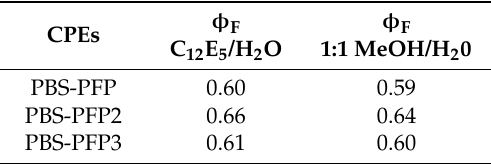
Table 1. Fluorescence quantum yields for the CPEs in study determined in co-solvent solution and using the non-ionic surfactant C 12 E 5 above its cmc in aqueous solution (50 µ